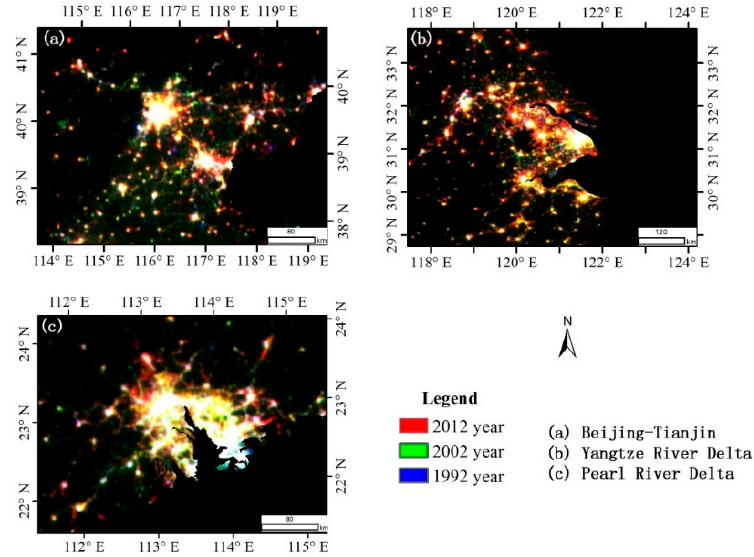
Figure 6. Color composite of nighttime light of three major urban agglomerations in China. ( a ) The Beijing–Tianjin–Hebei region; ( b ) the Yangtze River Delta; and ( c ) the Pearl River Delta.